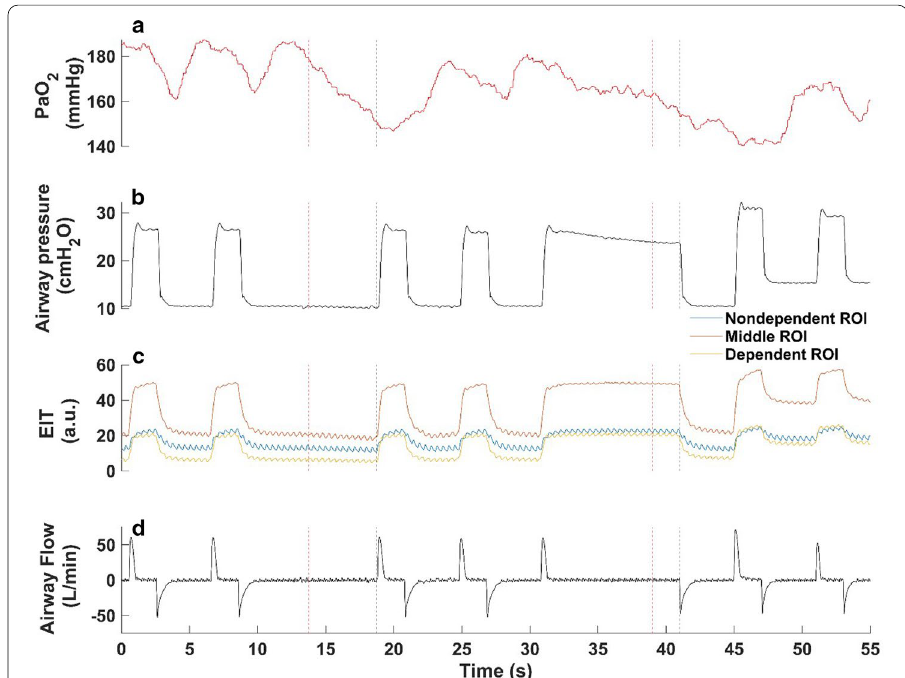
Fig. 2 Representative responses to breath-holding manoeuvres performed during expiration and